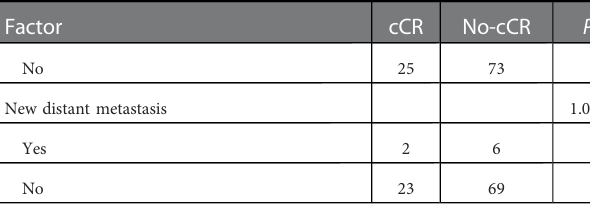
TABLE 1 Single-factor analysis of clinical factors affecting prognosis of CR after TNT treatment.